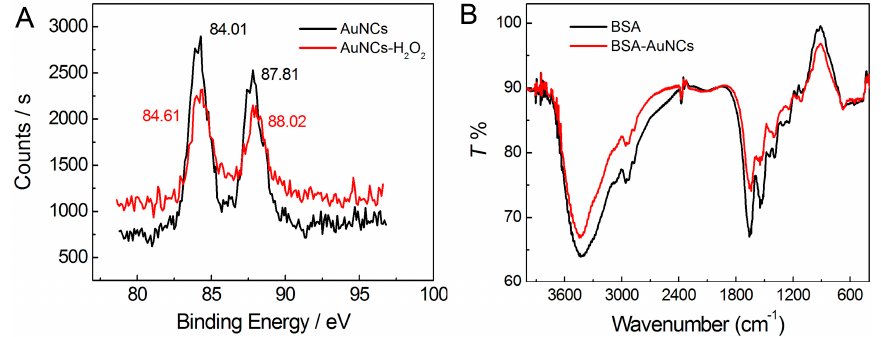
Figure 3. ( A ) XPS spectra showing the binding energy of Au 4f before and after the reaction with H 2 O 2 ; ( B ) FT-IR spectra of the pure BSA and BSA-stabilized AuNCs, respectively.